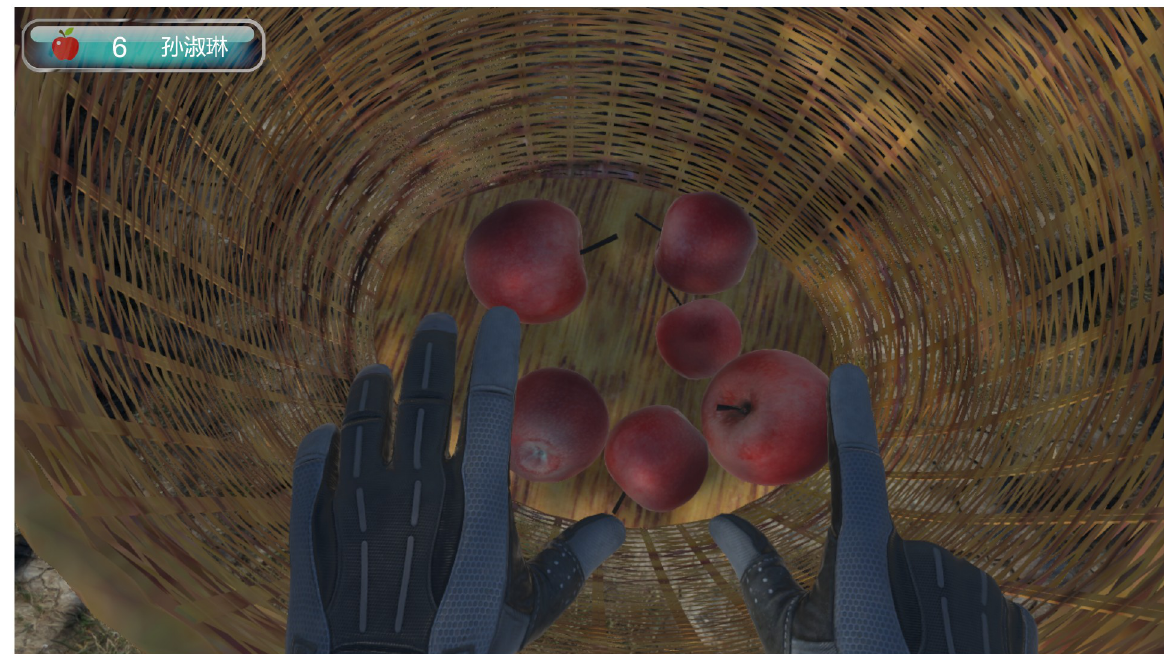
Fig 2. Screenshot of virtual reality rehabilitation interface (2).